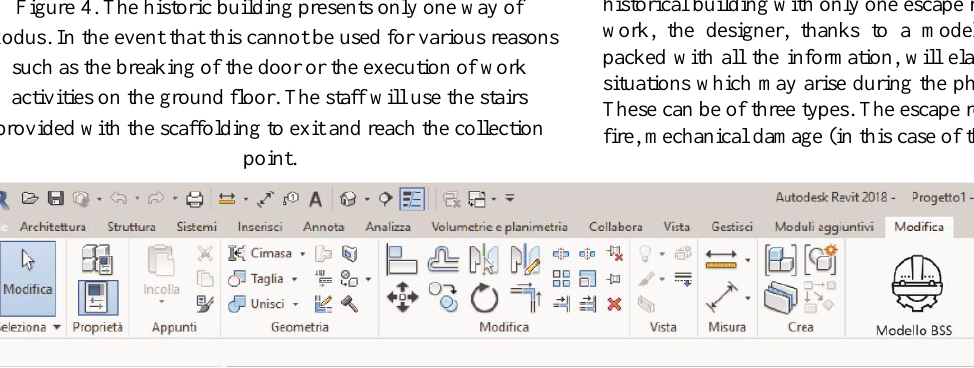
Figure 6. The introduction of the plug-in within the 3D BIM modeling